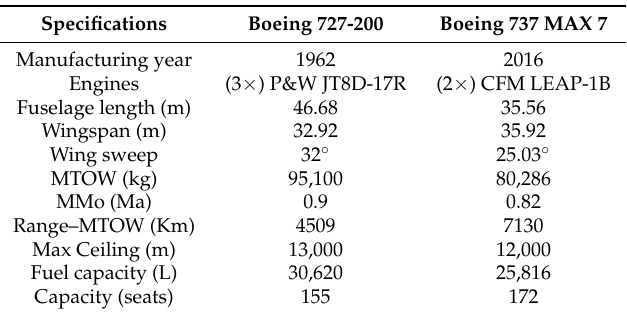
Table 1. Boeing 727-200 vs. Boeing 737 Max 7: Technical Specifications. Data from